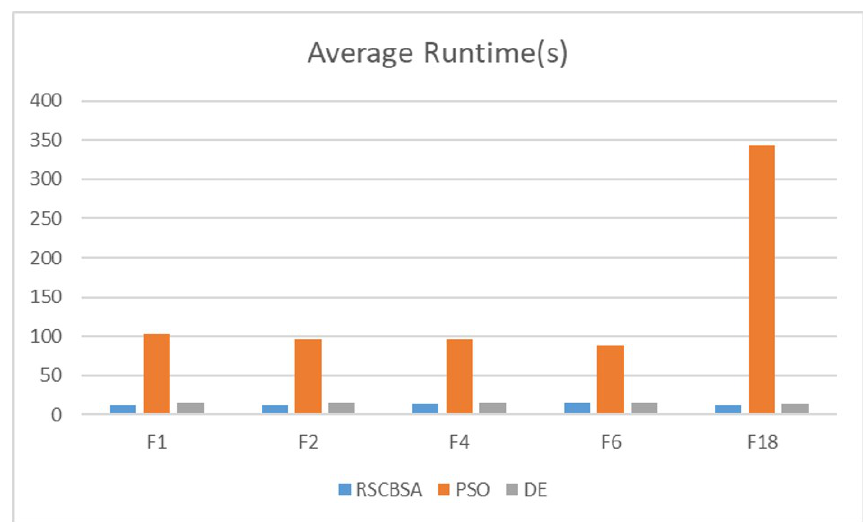
Figure 3. Runtime(s) of the three algorithms on five test